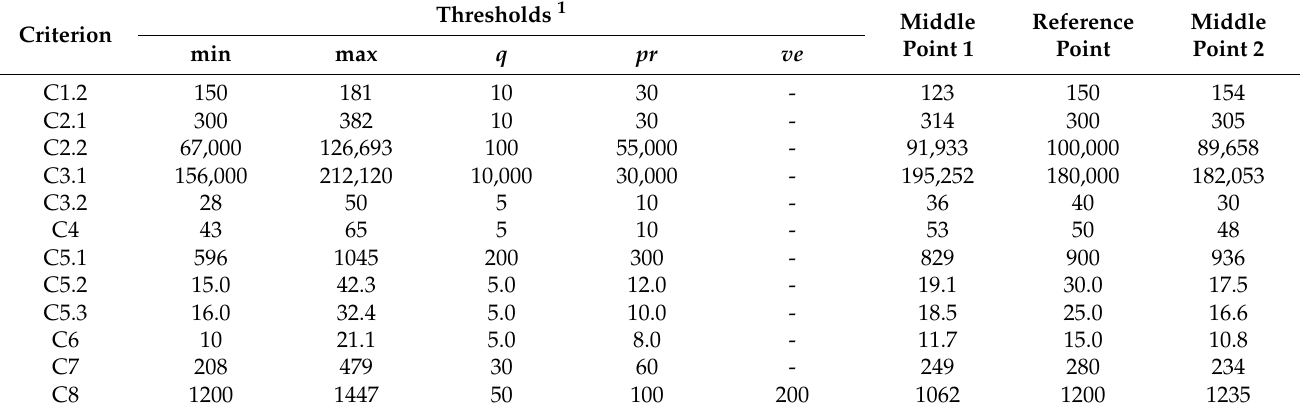
Table 8. Thresholds for the model of preference, middle and reference points (for Pareto-optimal alternatives).